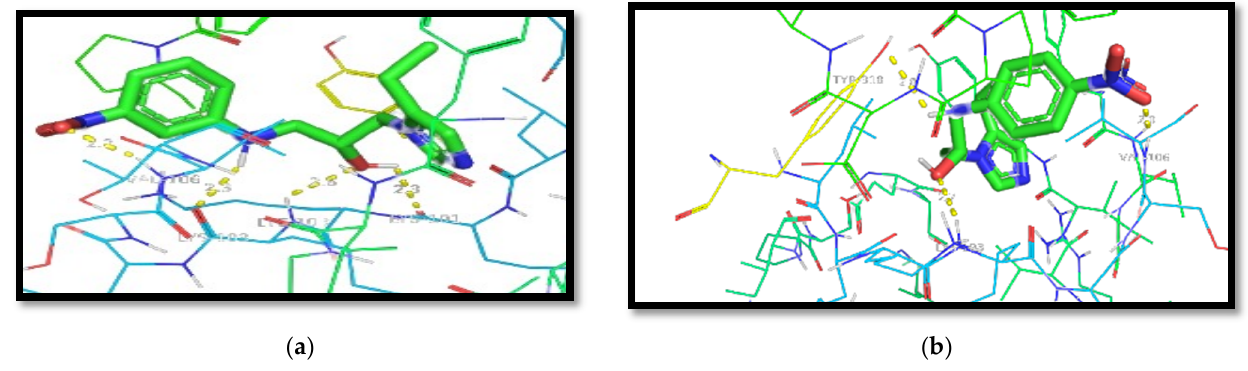
Figure 5. ( a ) Docking of compound 26p in the binding pocket of HIV-1 reverse transcriptase (1RT2). Ligand is shown as green line model and the amino acid residues interacting with the ligands are shown as conventional colored line model. Four hydrogen bond interactions (2.2, 2.3, 2.6, 2.3 Å) with amino acid residues of HIV-1 reverse transcriptase are shown in yellow dotted lines. ( b ) Docking of compound 26q in the binding pocket of HIV-1 reverse transcriptase (1RT2). Ligand is shown as green line model and the amino acid residues interacting with the ligands are shown as conventional colored line model. Three hydrogen bond interactions (2.0, 2.7, 2.8 Å) with amino acid residues of HIV-1 reverse transcriptase are shown in yellow dotted lines.